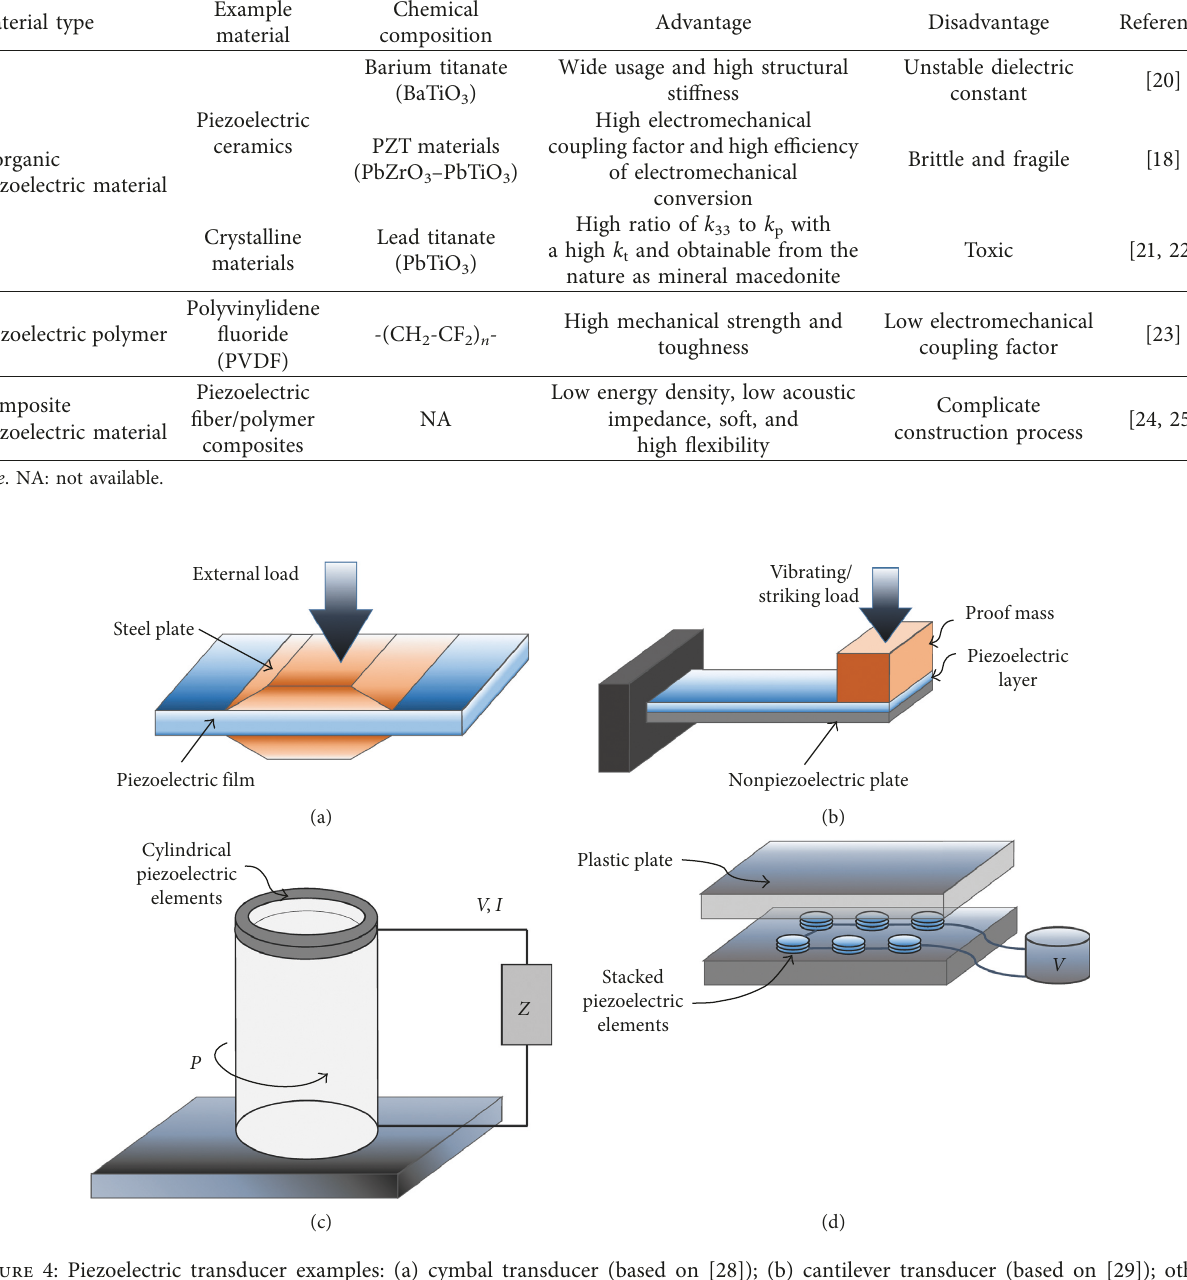
Figure 4: Piezoelectric transducer examples: (a) cymbal transducer (based on [28]); (b) cantilever transducer (based on [29]); other transducers: (c) cylindrical transducer (based on [30]) and (d) stacked piezoelectric transducers (based on [13]).